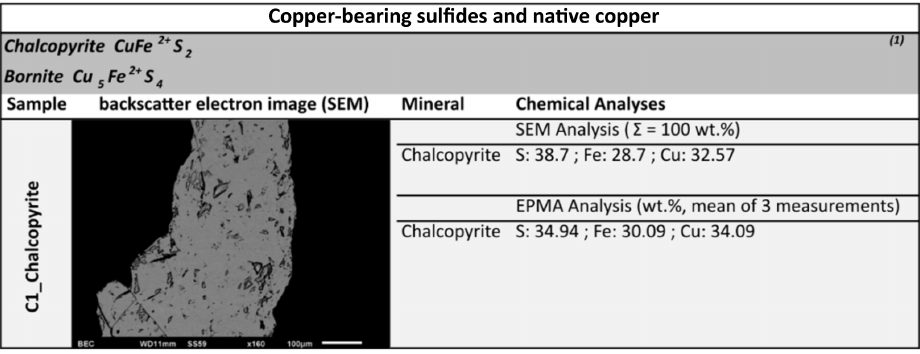
Figure 7. Sample C1_Chalcopyrite SEM and EPMA analysis. Table 7. Sample C1_Chalcopyrite EPMA analysis results, from three sample points on the sample. Element concentrations reported in wt% or as below detection limit